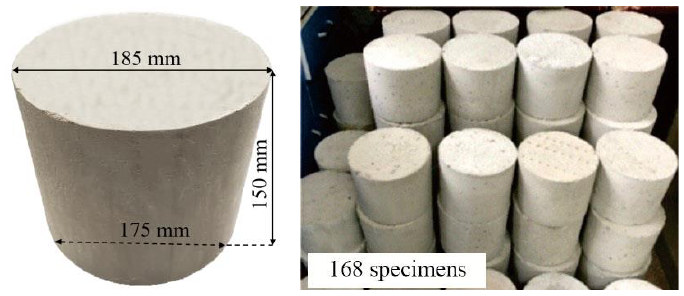
Figure 2. Detail of specimens.